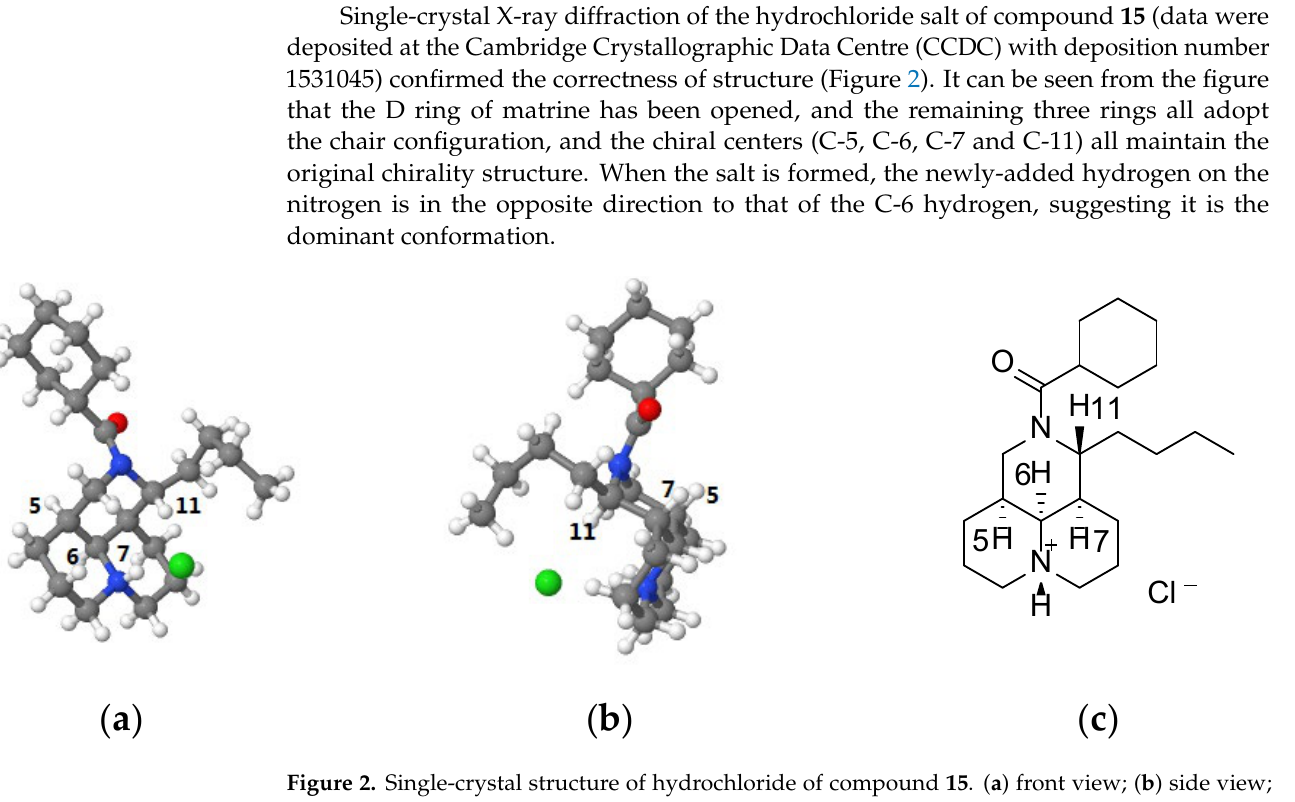
Figure 2. Single-crystal structure of hydrochloride of compound 15 . ( a ) front view; ( b ) side view; ( c ) structure of hydrochloride of 15 .